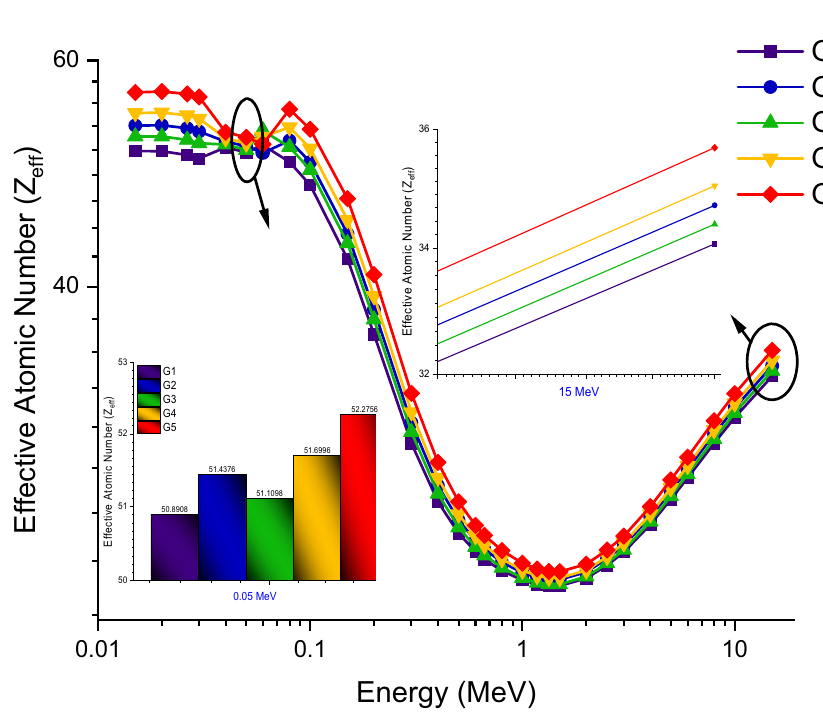
Figure 7: Variation of e ff ective atomic number ( Z e ff ) with photon energy ( MeV ) for all G1 – G5